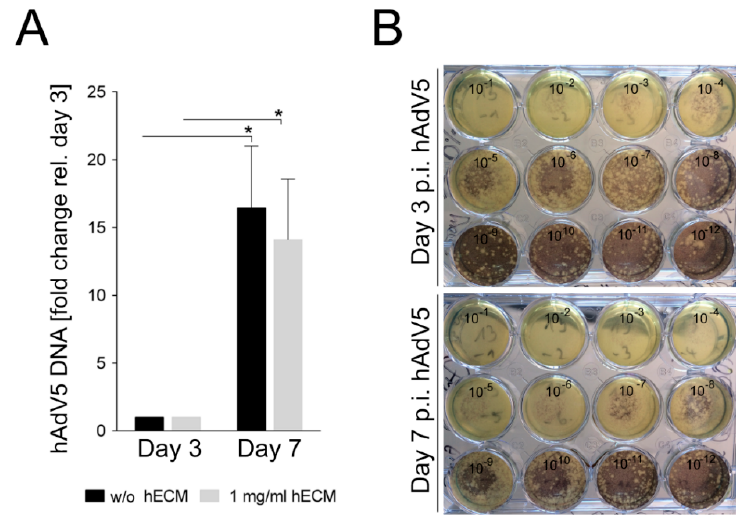
Figure 6. Adenovirus infection of printed mature HepaRG cells in alginate/gelatin bioinks containing hECM. ( A ) Analysis of adenoviral DNA replication, within the mature HepaRG cell-laden 3D alginate/gelatin constructs, determined by quantitative polymerase chain reaction (qPCR). Comparison of constructs without and with 1 mg/mL hECM three and seven days after infection. The adenoviral DNA amount three days post infection with Adv5 was used as reference to assess the course of viral infection seven days post infection. Results are shown as mean ± SEM of three independent